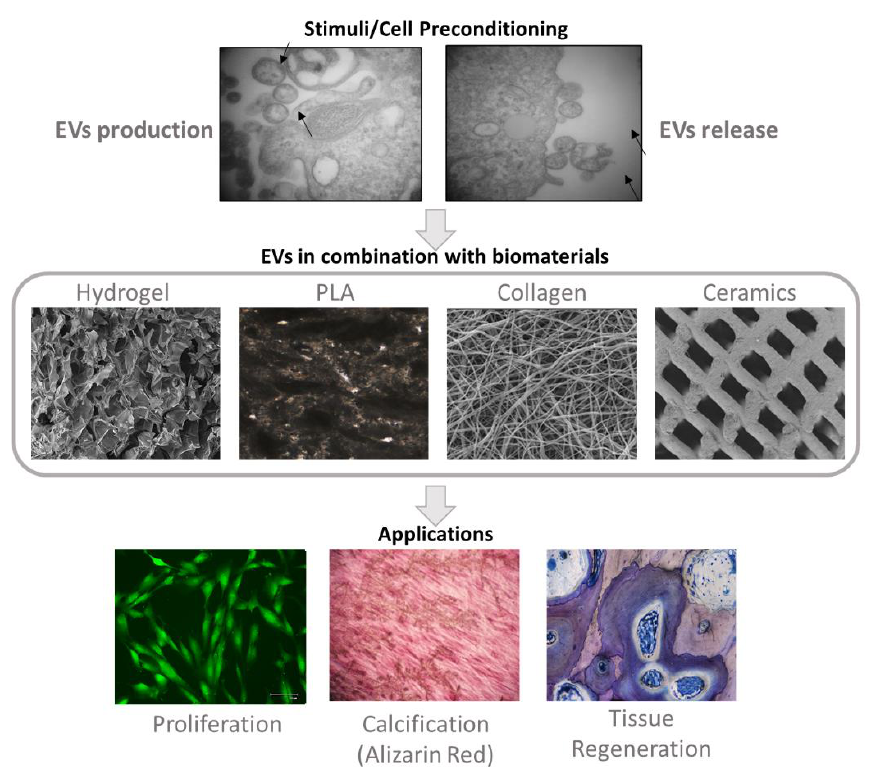
Figure 2. Engineering EVs and Their Applications. Cell preconditioning/engineering may increase the production and secretion of EVs, while also modulating its content in a controlled manner. These vesicles can then be delivered in combination with scaffold/biomaterials to ensure correct targeting, by conferring protection to the EVs and allowing a controlled release of their content. Thus, this strategy can lead to an improvement in tissue regeneration, through stimulation of several cell processes including proliferation, calcification and differentiation. The images depicting EVs production and release were obtained by Transmission Electron Microscopy (TEM); PLA and tissue regeneration images were obtained by the ground sections method in brightfield imaging; hydrogel, collagen and ceramics images were obtained by Scanning Electron Microscopy (SEM); the image representing proliferation was captured by confocal microscopy; the Alizarin Red staining used to detect calcification was captured in brightfield microscopy. All images belong to the authors.